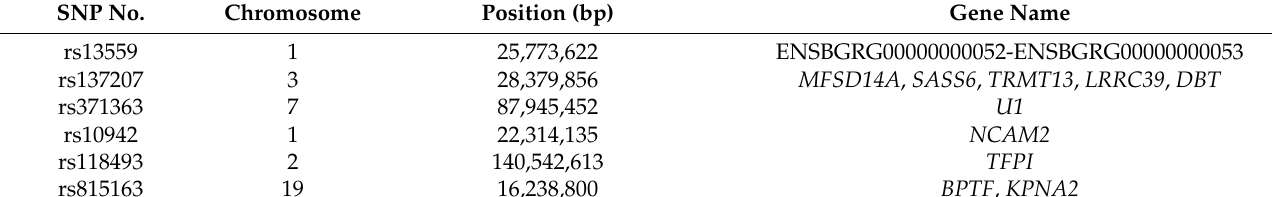
Figure 3. Manhattan plots with all genotypes with three GWAS methods. The GWAS results of three GWAS methods were integrated into circle multiple Manhattan plots ( A ). The outer ring is the marker density and the significant markers were marked as red star. The markers detected by more than two methods were drawn with gray string line. The QQ plots of multiple methods were also integrated into figure ( B ). Figure 4. Phenotype distribution among the genotypes of the associated SNPs. The population was divided with the genotype of associated SNPs containing rs13559 ( A ), rs137207 ( B ), and rs371363 ( C ). In the figure there is only one individual with AA or GG genotype for SNP rs13559 or rs137207. For these three associated SNPs, there are no heterozygous genotypes observed in all individuals. Table 1. The candidate genes’ information of associated significant SNPs in the 200 kb region. The SNP No. indicates order number in the whole marker list. The chromosome and position mean the physical location information in the genome data. The gene names were annotated from GTF file in the BosGru_v3.0 reference genome. The values in the brackets are distance of base pair between